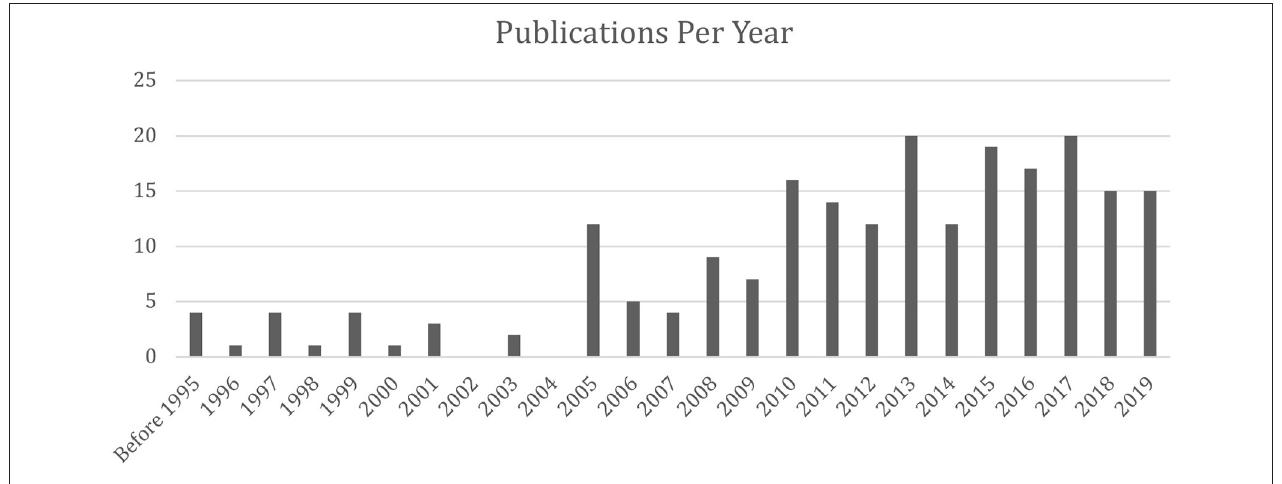
FIGURE 1 | Critical social science publications in sport management per year ( N = 216).